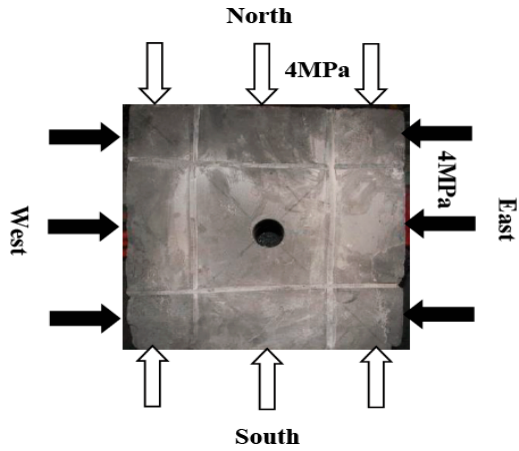
Figure 2. Schematic of the applied horizontal stress.